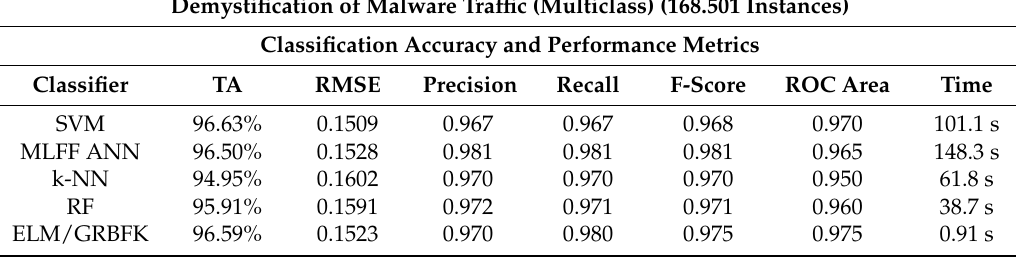
Table 3. Comparison between